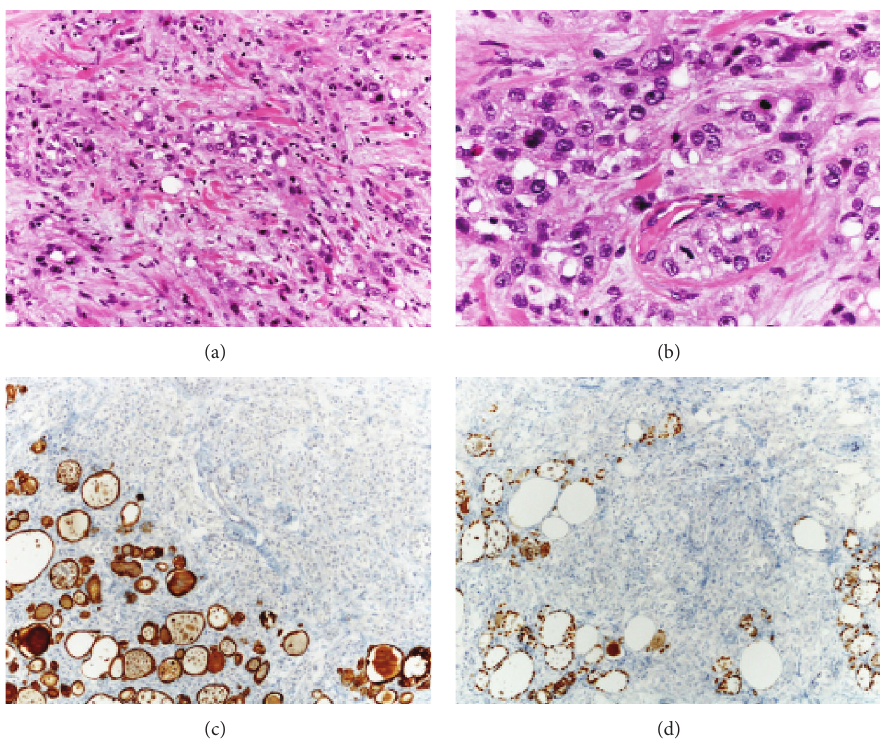
Figure 7: An ATC made up of pleomorphic epithelioid cells arranged in loosely cohesive nests; focally, intracytoplasmic vacuoles are present ((a), (b)). Immunohistochemical stains with keratin 7 (c) and TTF1 (d) highlight entrapped thyroid